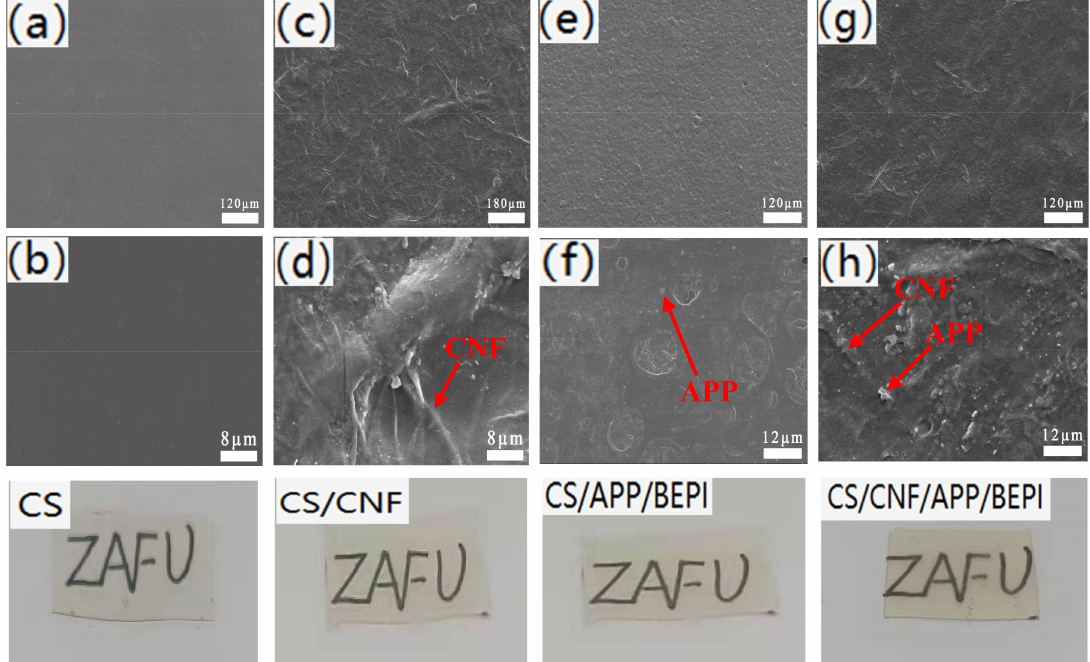
Figure 2. SEM images of the ( a , b ) pure CS, ( c , d ) CS/CNF, ( e , f ) CS/APP/BPEI, and ( g , h ) CS/ CNF/APP/BPEI composite films and their illustrations showing transparency.